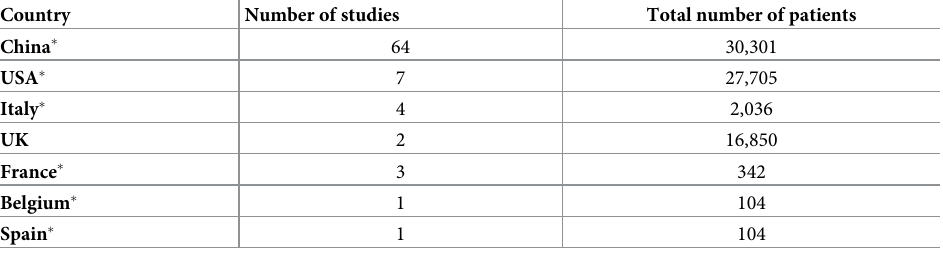
Table 1. Number of studies by country and Covid-19 patients